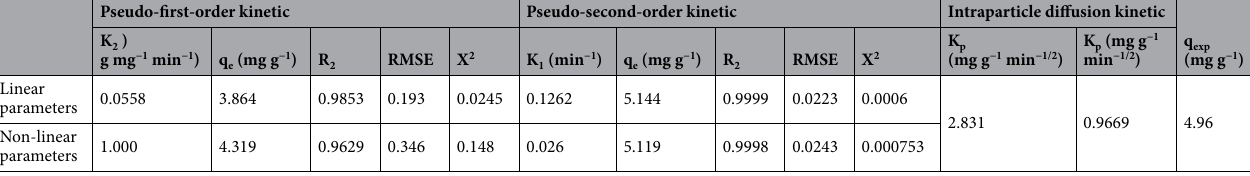
Table 9. Information of linear and non-linear kinetic models for RR 198 adsorption onto MSW compost ash.